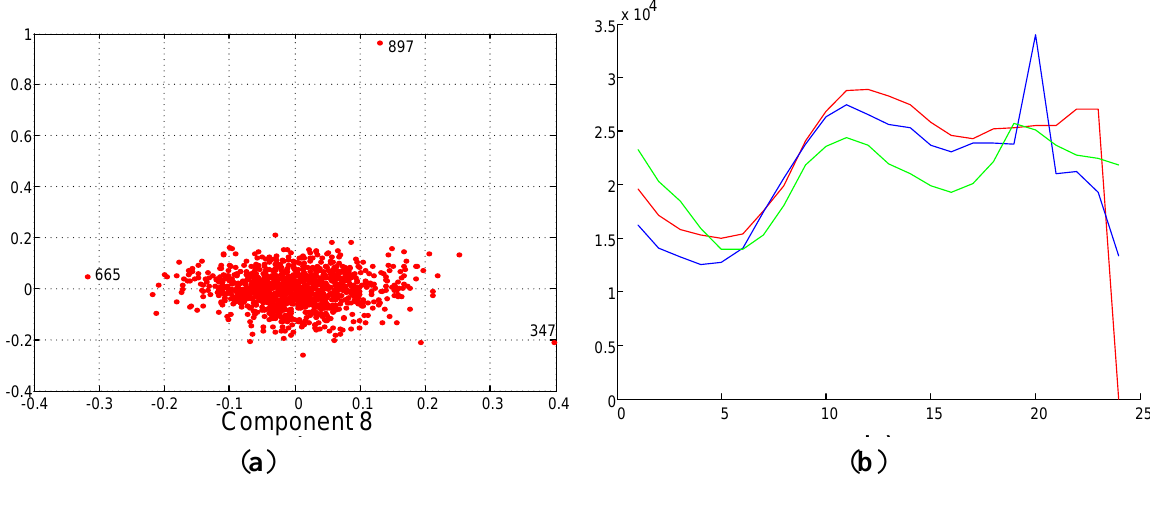
Figure 5. On-line operation of the